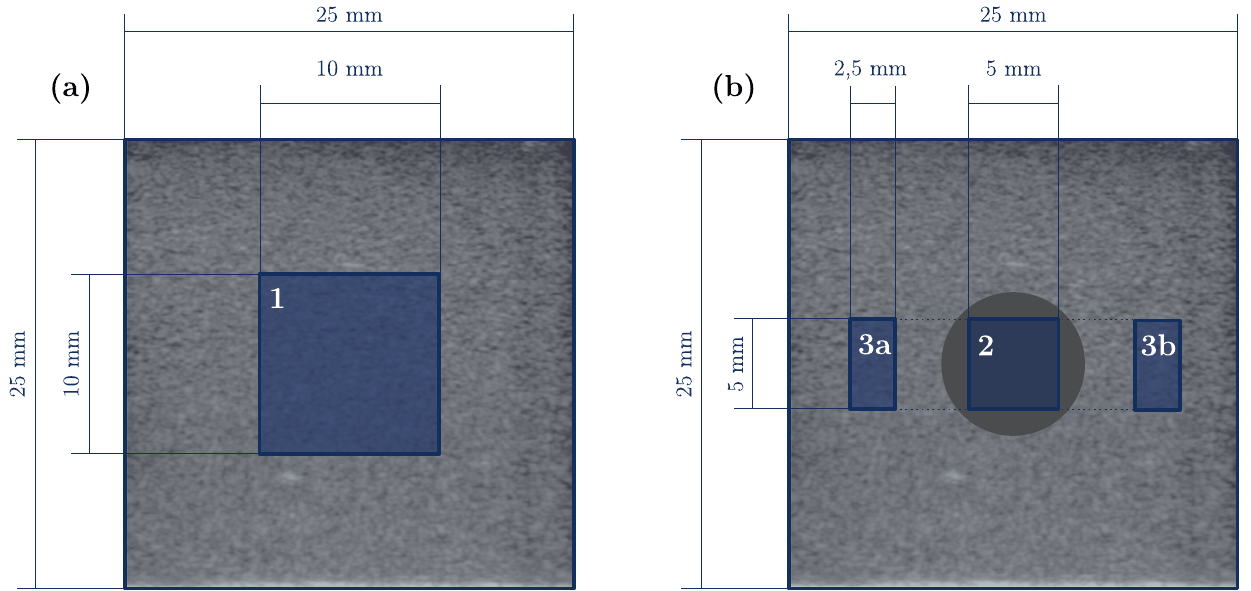
Figure 13. The chosen regions of interest (ROIs) to evaluate the mean Young’s modulus: ( a ) Region 1 is used to evaluate the mean Young’s modulus for homogeneous specimens. ( b ) Region 2 defines the ROI of the inclusion material and the regions 3a,b are combined to calculate the mean Young’s modulus of the body material.